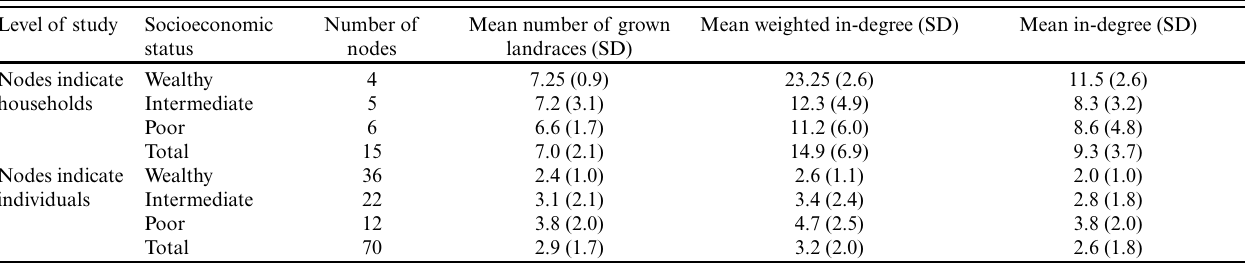
Table 2. Number of grown landraces, weighted in-degree, and in-degree by socioeconomic stratum. Level of study Socioeconomic Number of Mean number of grown status nodes landraces (SD)